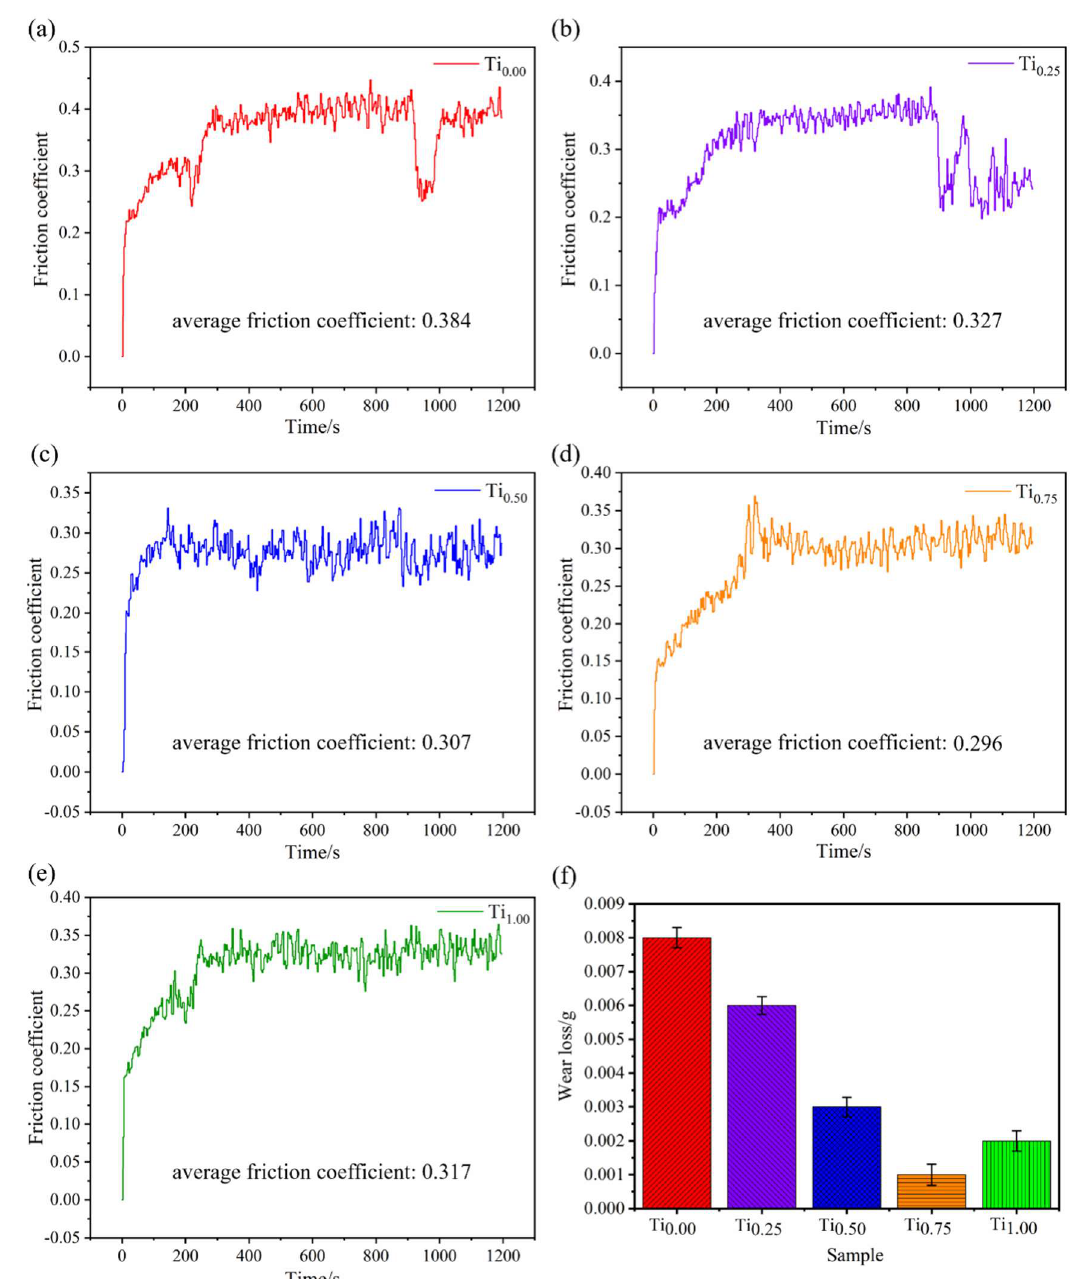
Figure 7. Friction coefficient curves of CoCrFeMnNiTi x alloy coatings with different Ti contents: ( a ) Ti 0 , ( b ) Ti 0.25 , ( c ) Ti 0.5 , ( d ) Ti 0.75 , ( e ) Ti 1 , and ( f ) wear loss of CoCrFeMnNiTi x high － entropy alloy coatings with different Ti contents.